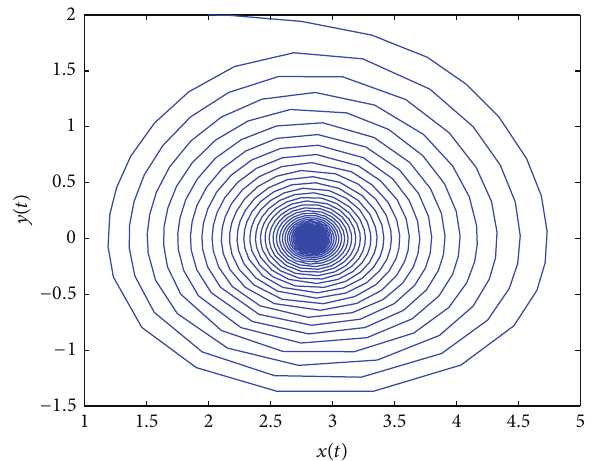
Figure 2: 𝜏 1 = 0 , 𝜏 2 = 0.68 , (𝑝 ∗ ,0) is asymptotically stable.